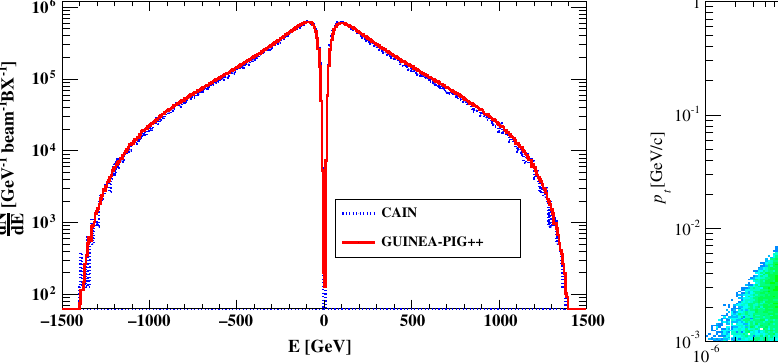
FIG. 4. Distribution of opposite-charge (focused) coherent pairs after one bunch crossing using the 3 TeV CLIC baseline design parameters. On the z axis is the number of particles in each bin, per bunch